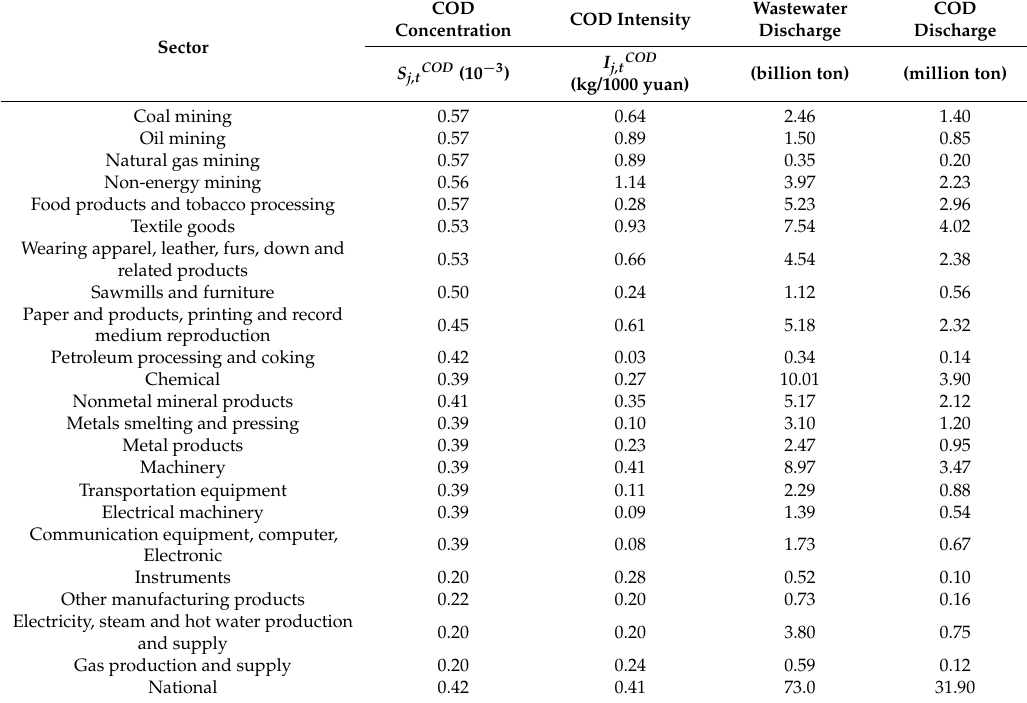
Table 1. The values of coefficients in the discharge equations used to estimate COD discharge in 2014. COD COD Concentration Sector